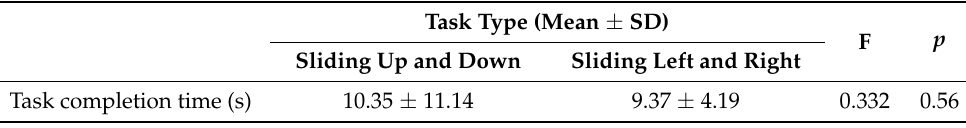
Table 3. Variance analysis of task completion time in different sliding modes.